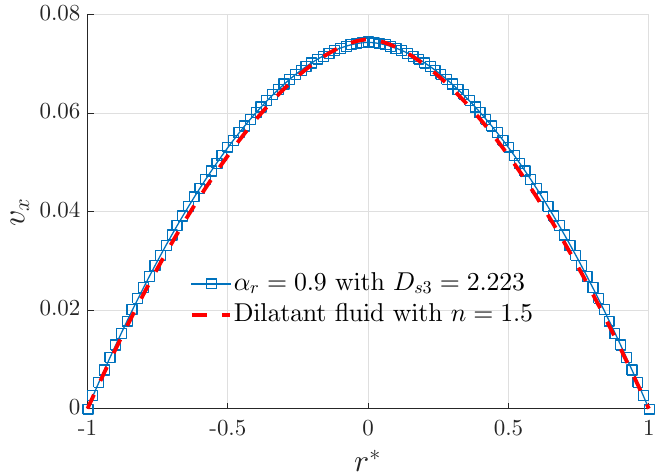
Figure 8. Plots of the velocity profile defined by Equation (28) for α r = 0.9 and D s 3 = 2.223, compared with the velocity distribution of a dilatant fluid with index n = 1.5, with r ∗ = r / r e , d x = 0.9, ∆ p = 25 Pa, µ = 10 − 3 Pa.s, and c = 100 m 1 − γ